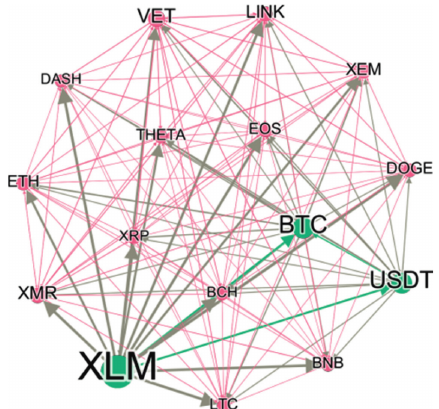
Figure 46: Risk spillover under E7.